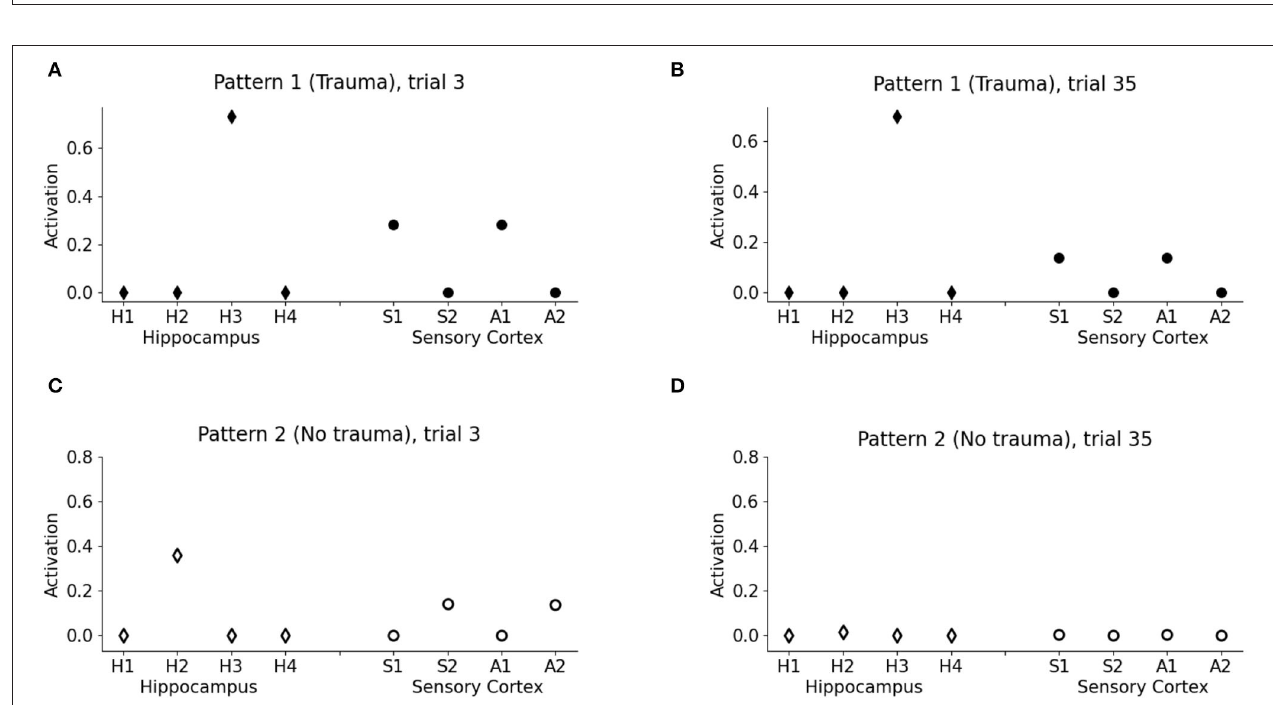
FIGURE 3 | Model memory formation in PTSD and control conditions. (A) The graph corresponds to trial 3 of Figure 2 in the condition with the trauma. V1 activates the hippocampal unit H3 and the cortical units S1 and A1 encoding the other elements of pattern 1. (B) The graph corresponds to trial 35 of Figure 2 in the trauma condition. The memory trace continues to be activated by V1 even after many trials. (C) The graph corresponds to trial 3 of Figure 2 in the control condition with no trauma. V2 activates H2, a different unit of the hippocampus with respect to V1, and also the other cortical elements of the pattern, S2 and A2, although to a lesser extent with respect to PTSD [note the different scales in (A,C) ]. (D) The graph corresponds to trial 35 of Figure 2 in the control condition. After 35 trials, the memory trace is lost and V1 does not elicit activations (the memory has been transferred to the